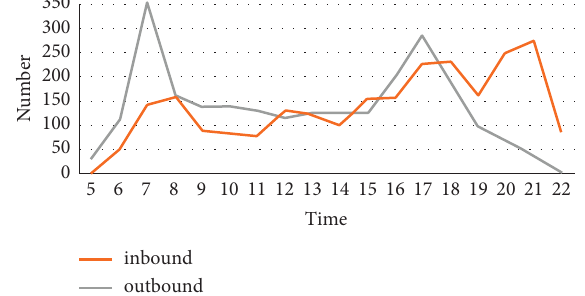
Figure 7: Passenger flow statistics of the subway station in the commercial area.